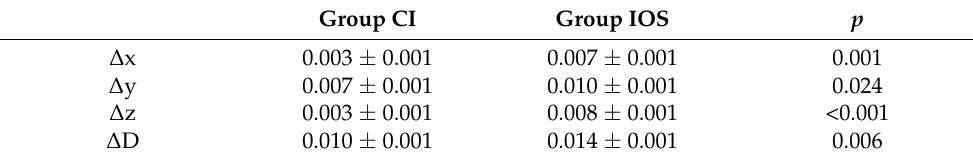
Table 3. Linear mixed model analysis. Estimated mean values (mm) ± standard error.